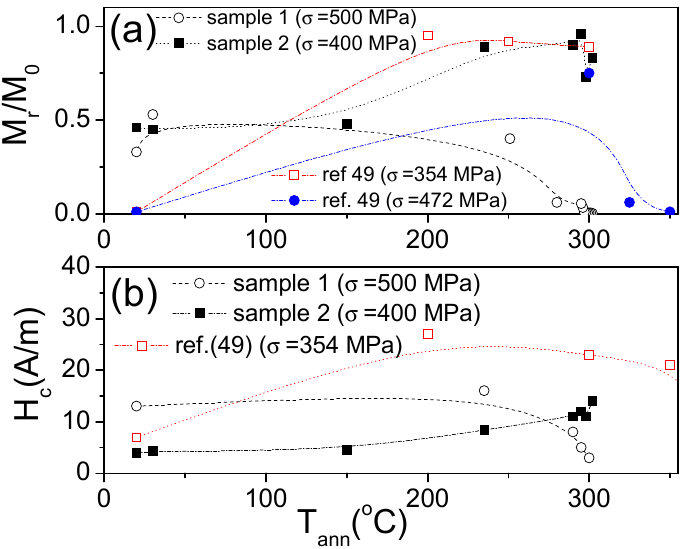
Figure 9. Comparison of M r /M 0 (T ann ) ( a ) and H c (T ann ) ( b ) dependencies for samples 1 and 2 and for the Co 69.2 Fe 3.6 Ni 1 B 12.5 Si 11 Mo 1.5 C 1.2 microwires studied in the Refs. [47–49]. The lines are just guides for the eyes.